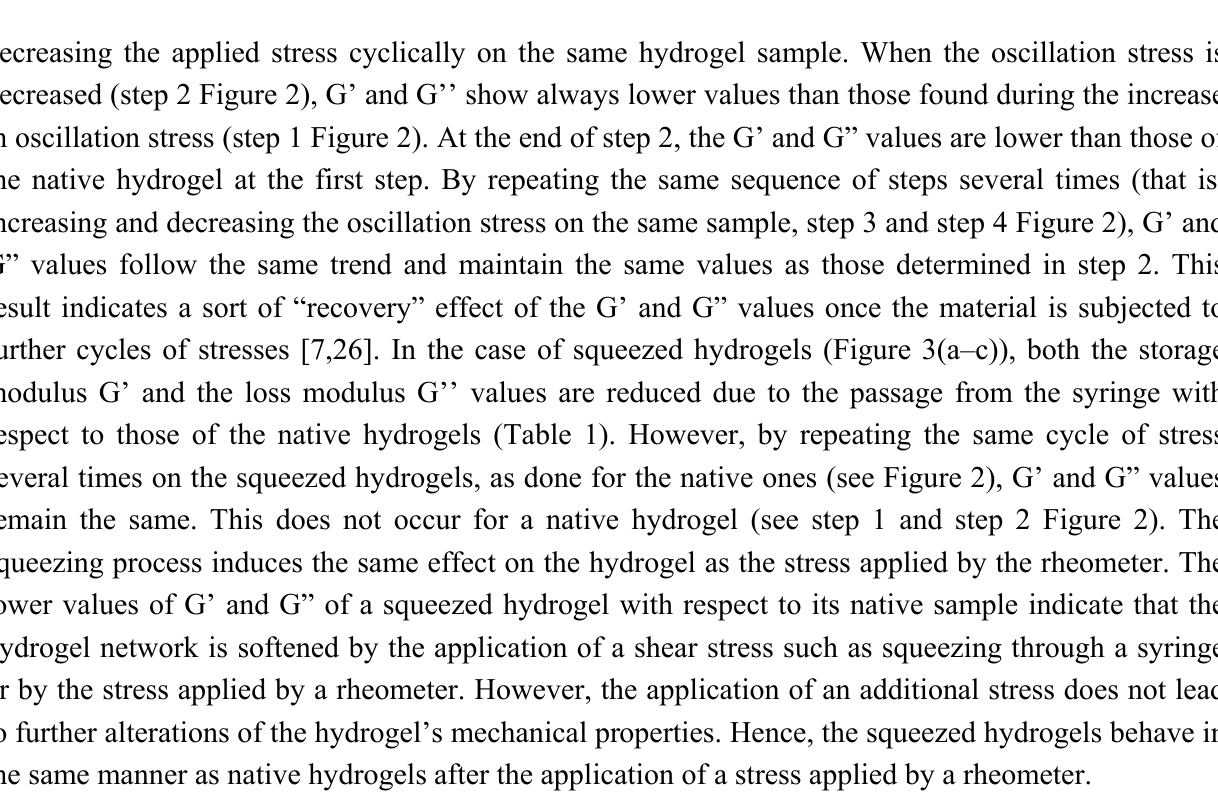
Figure 2. Typical trend of G’ and G” values vs . oscillation stress during sweep test performed on a polysaccharide-based hydrogel. The figure shows the G’ and G” value vs . oscillation stress for each step of the